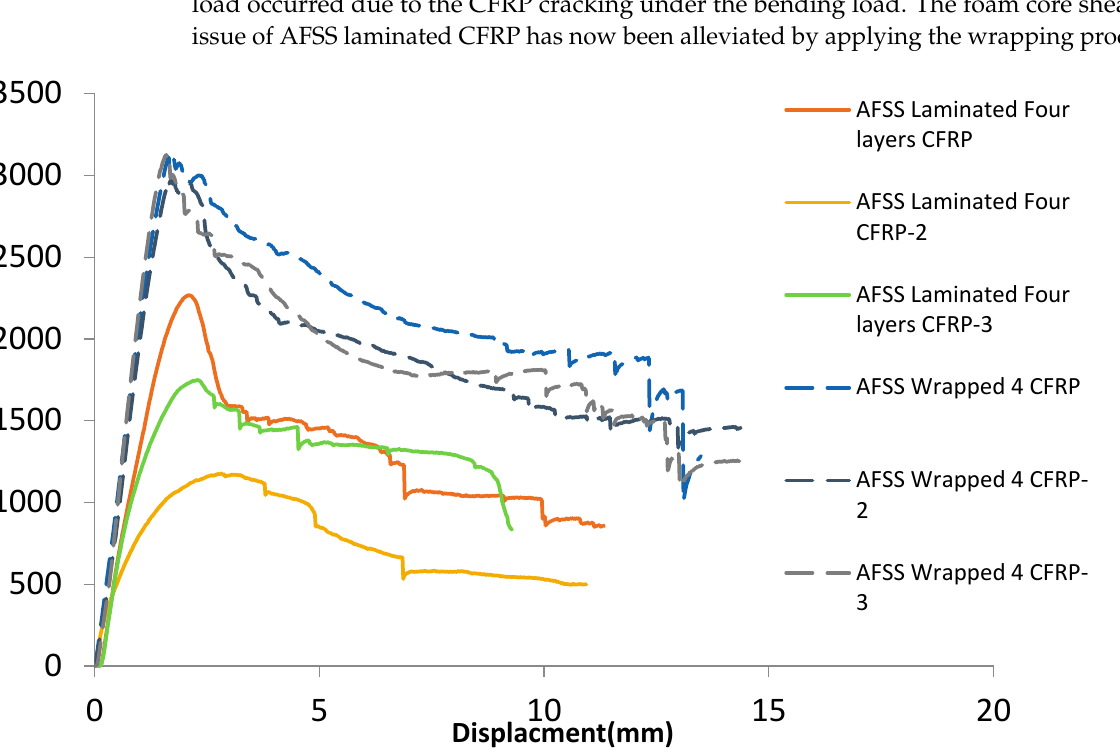
Figure 8. Load displacement curved of AFSS and AFSS wrapped around four layers CFRP.